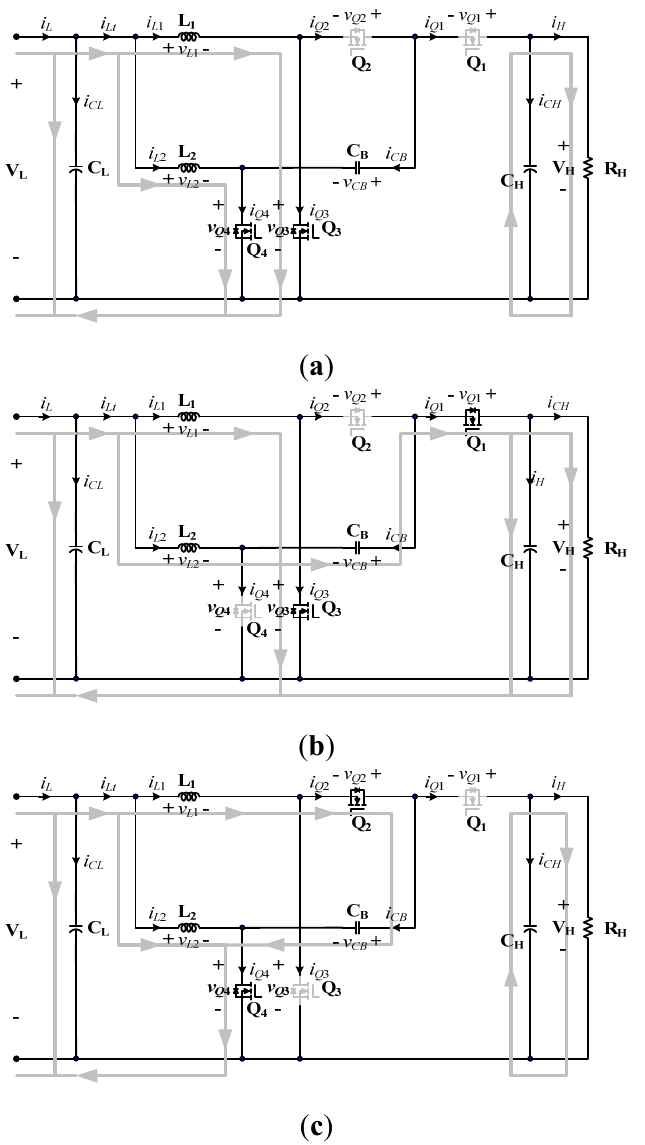
Figure 8. Operating modes of the proposed converter in the discharge mode operation. ( a ) Mode 1 and Mode 3; ( b ) Mode 2; and ( c ) Mode